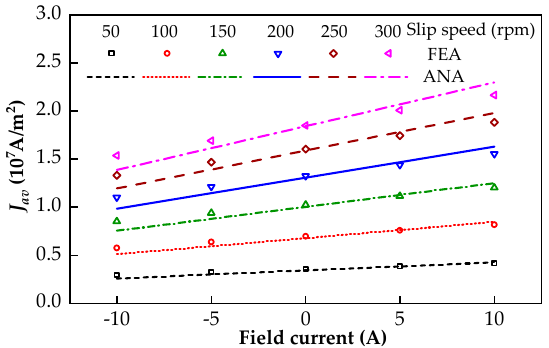
Figure 9. The average eddy current densities under different slip speeds.